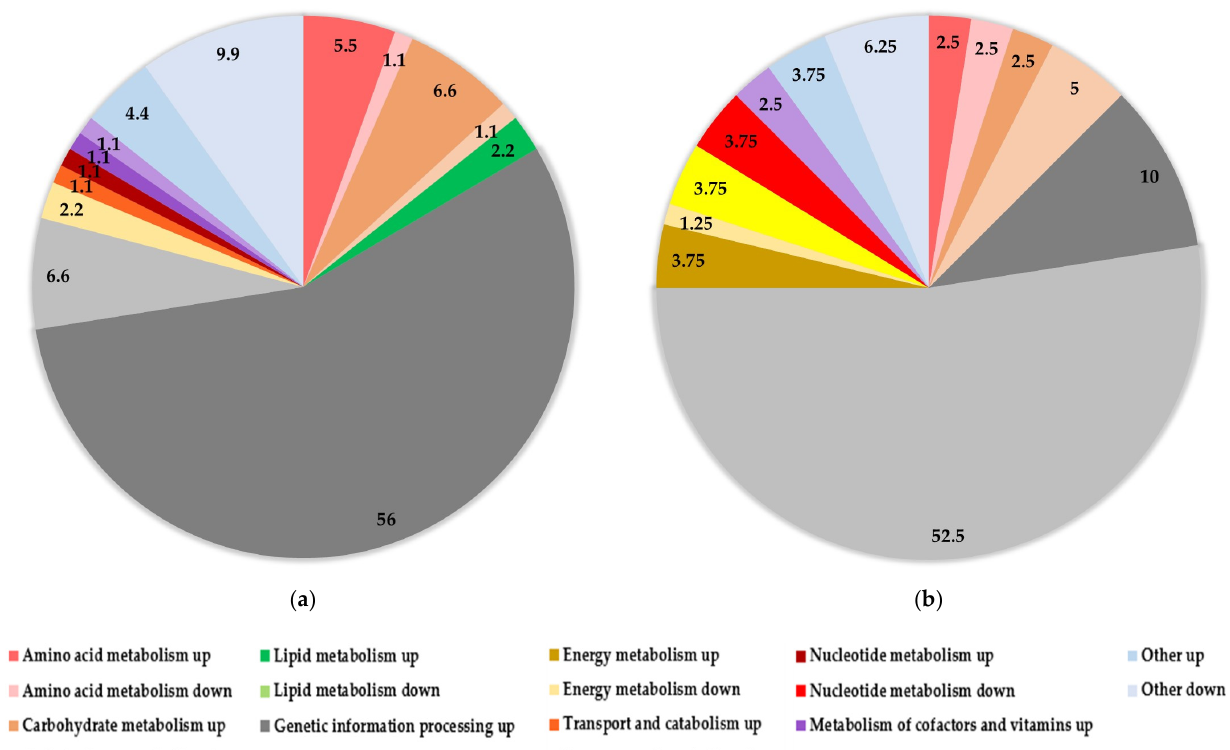
Figure 3. Pie charts showing differentially abundant protein profiles in yeast treated with fermented Spirulina extract (S) compared to yeast treated with non-fermented Spirulina extract (NF). Results are expressed in percent (%) of significantly upregulated or downregulated proteins involved in different cellular processes. The darker shade of the same color represents the upregulated proteins involved in a specific cell process, and the lighter shade of the same color represents the downregulated proteins involved in the same cell process. ( a ) Yeast treated with water extracts (SV compared to NFV); ( b ) Yeast treated with ethanol extracts (SE compared to NFE).